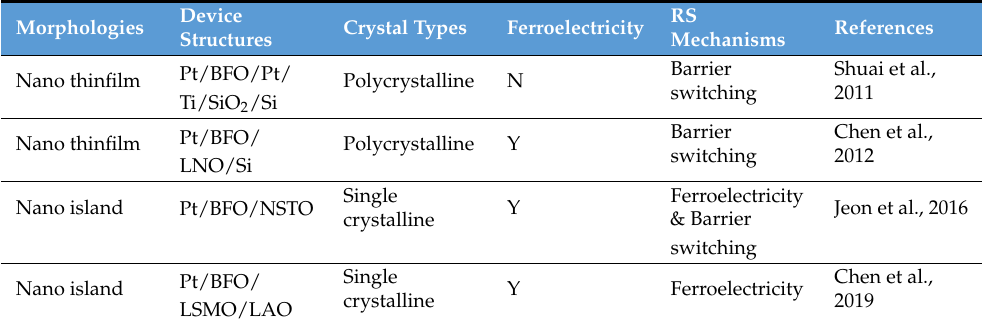
Table 1. Crystal symmetry and microstructure of devices based on rhombohedral BFO, including morphologies, device structures, crystal types, ferroelectricity, and RS mechanisms in Ref. [7,17,25,53].